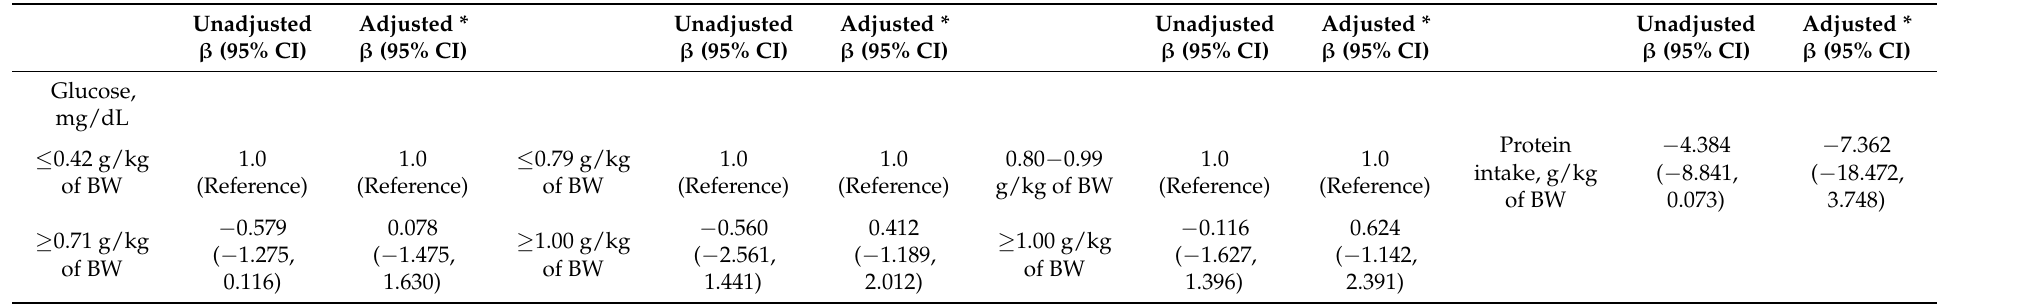
Table 5. Association between protein intake and blood